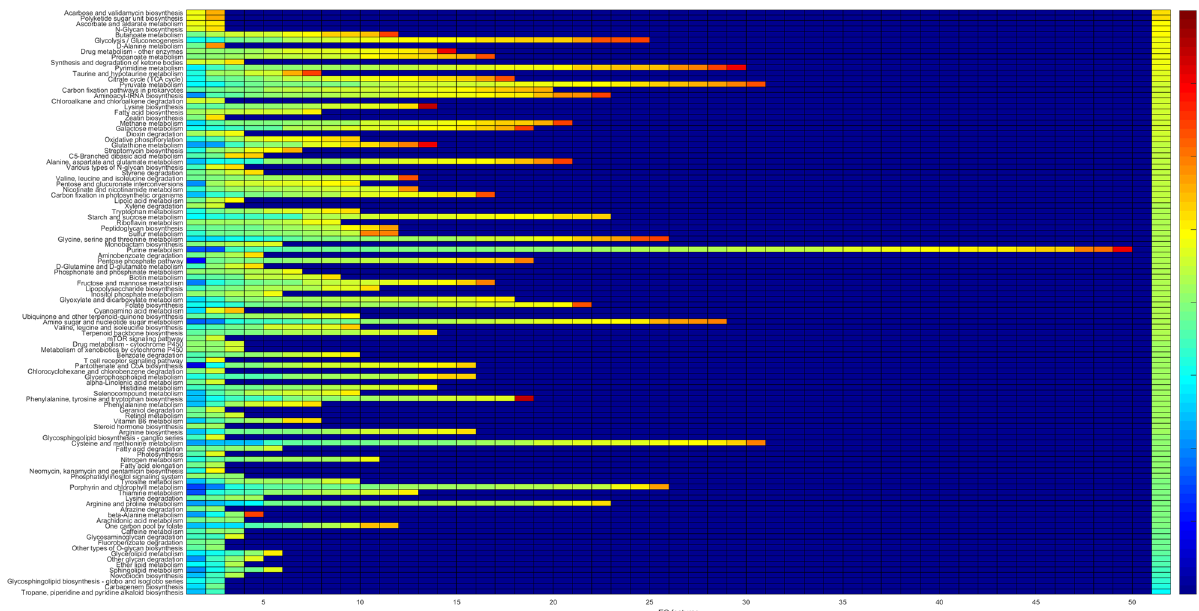
Figure 3. Pathway changes in COVID-19 samples. For each pathway (row), there are as many entries as there are detected EC features. The color of the entries indicate the average of COVID-19 versus CAP and COVID-19 versus HC changes. The entries on each row are ordered from low to high values. The background value (dark blue) indicates no data; some pathways have more detected features than others (only pathways with at least two EC features detected are considered). The rightmost column indicates the pathway score, the pathways are ordered accordingly from top (higher in COVID-19) to bottom (lower in COVID-19).